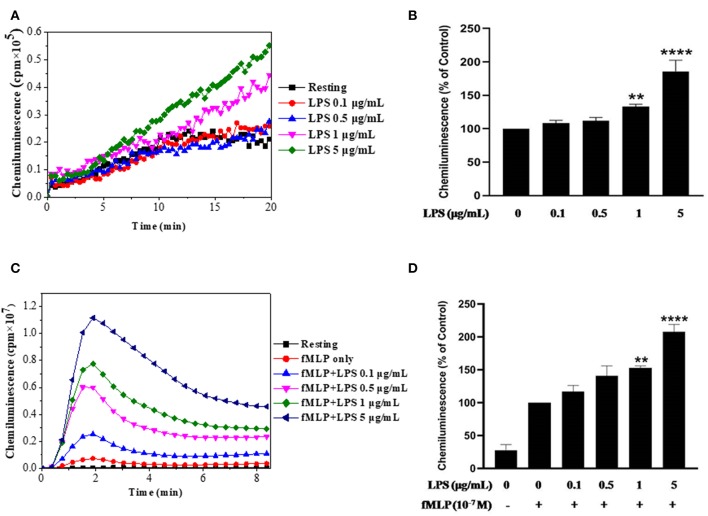
Effect of LPS alone or in combination with fMLP on ROS production by human neutrophils. (A) Human neutrophils (1 × 106/ml) were incubated in HBSS without or with different concentrations of LPS for 20 min at 37°C. ROS production was measured using a luminol-amplified chemiluminescence technique. (B) Total chemiluminescence in each experimental condition is expressed as mean plus or minus SEM of 3 different experiments as compared to untreated cells (control 100%). (C) Human neutrophils (1 × 106/ml) were incubated in the presence or absence of increasing concentrations of LPS for 20 min at 37°C, then stimulated with fMLP (10−7M). (D) Data are mean plus or minus SEM of 5 experiments as compared to fMLP only (control 100%) (**p < 0.05, ****p < 0.01).